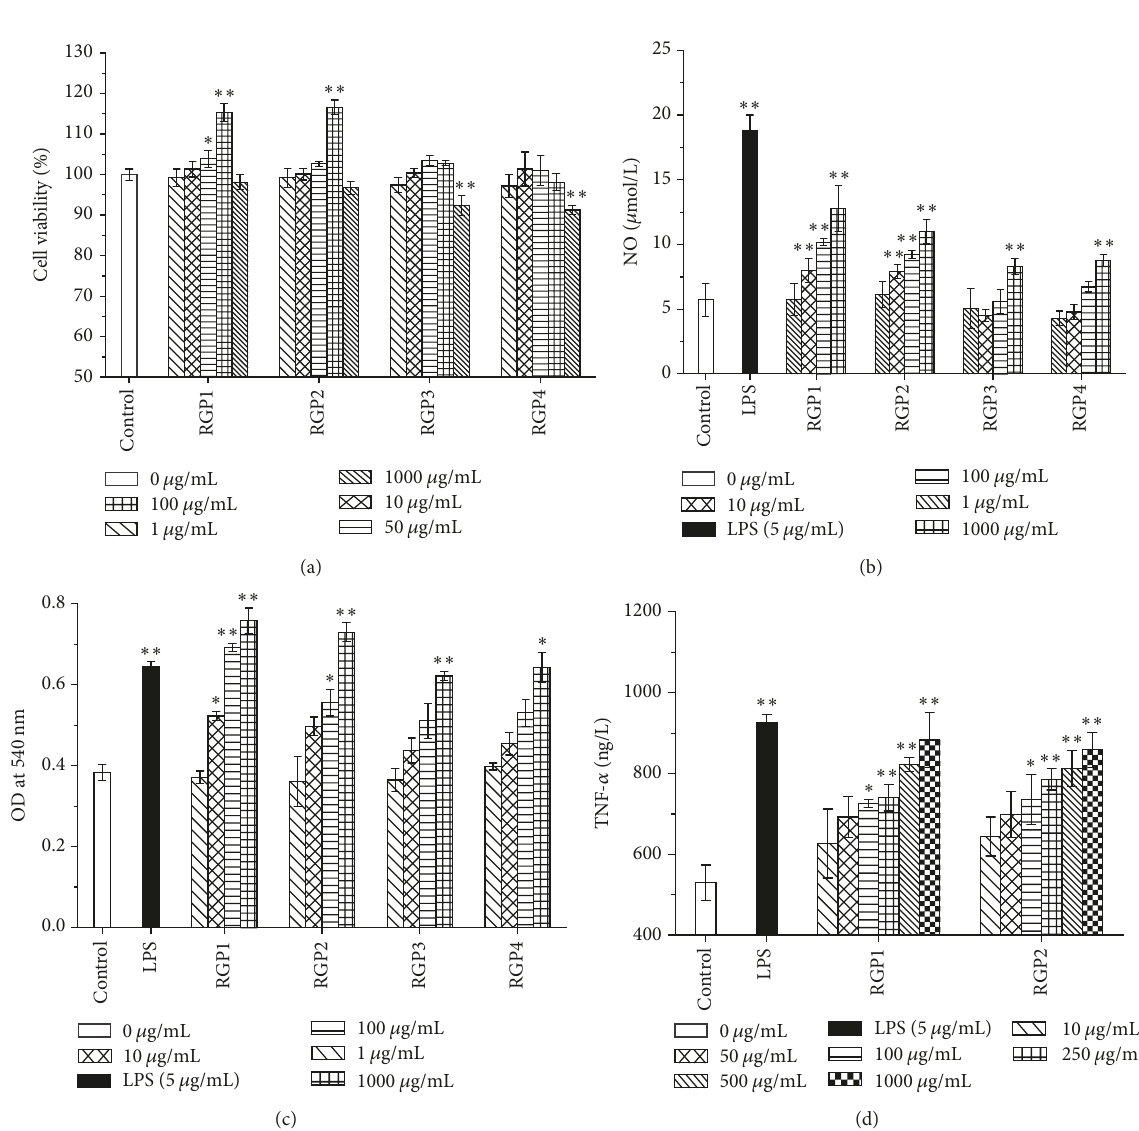
Figure 2: Immunomodulatory activities of red ginseng polysaccharide fractions in RAW 264.7 cells. (a) Effects of RGP1, RGP2, RGP3, and RGP4 on RAW 264.7 cell viability. (b) Effects of RGP1, RGP2, RGP3, and RGP4 on NO production. (c) Effects of RGP1, RGP2, RGP3, and RGP4 on phagocytic activity. (d) Effects of RGP1 and RGP2 on TNF- 𝛼 production. Each value was expressed as mean ± SD ( 𝑛 = 3 ). ∗ indicates 𝑝 < 0.05 ; ∗∗ indicates 𝑝 < 0.01 compared with the control